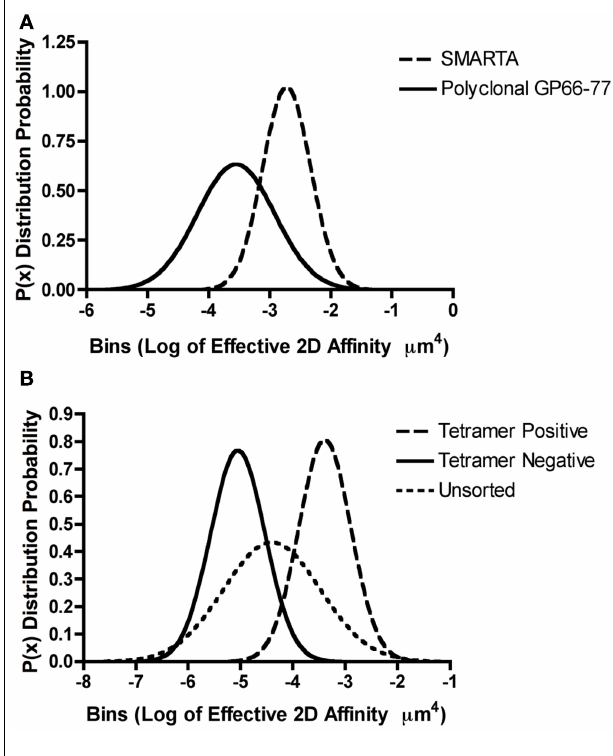
FIGURE 2 | Range ofTCR affinities for an individual pMHC in a polyclonal repertoire . (A,B) Gaussian distributions were modeled for the describedT cells by utilizing previously published effective 2D affinity means and standard deviations using the equation P ( x ) = 1/[ σ × sqrt(2 π ) × e ∧ ( − ( X − µ ) ∧ 2/(2 s ∧ 2)] where P ( x ) is the probability density function or distribution, σ is the standard deviation, X is the